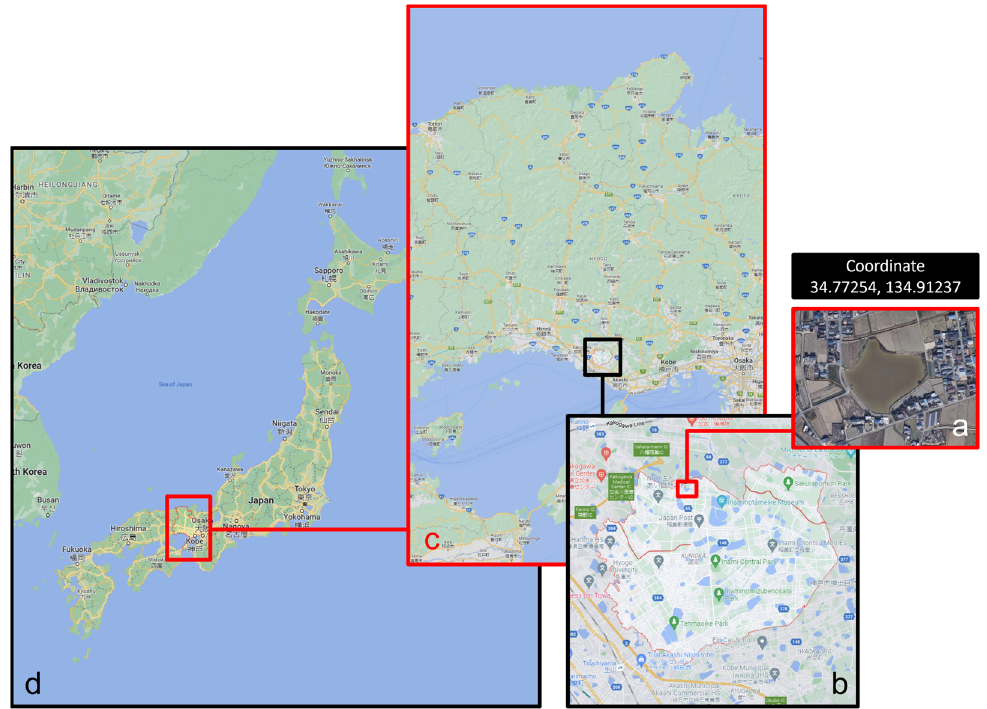
Figure 3. Location of the Ohzawashinike pond ( a ) in Inami Town ( b ), Hyogo ( c ), Japan ( d ). The solar panels in the floatovoltaic system should cover the pond’s surface by up to